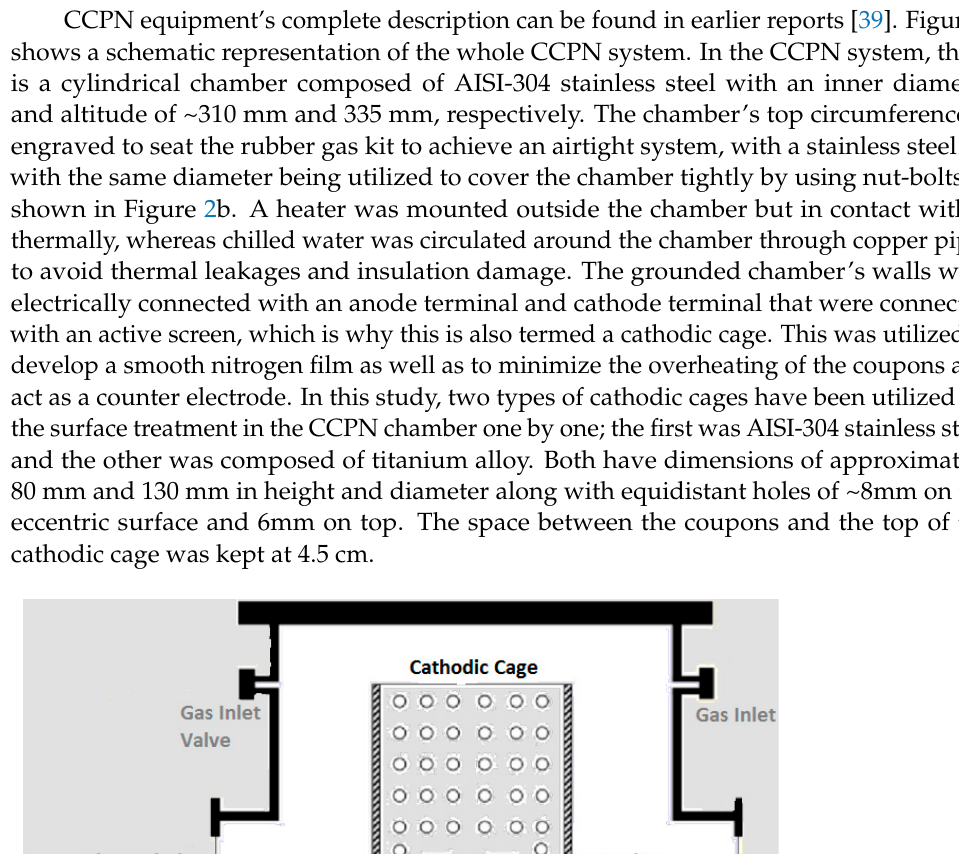
Table 1. Chemical composition of AISI430 ferritic steel sample.